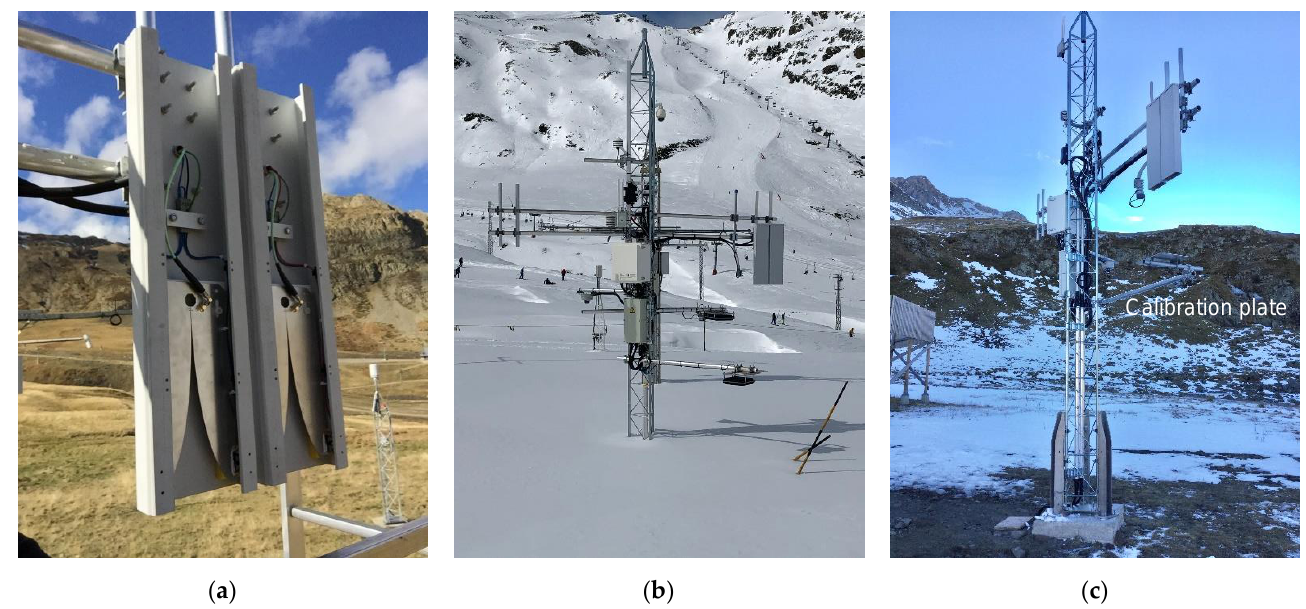
Figure 12. ( a ) Detail of the emission and reception antennas. At the bottom, we can see the heating resistors. ( b ) Overview of the complete system showing the flatness of snowpack in the work area. ( c ) Virtual “0” calibration plate (CP) placed at 254 cm of the metal sheet.